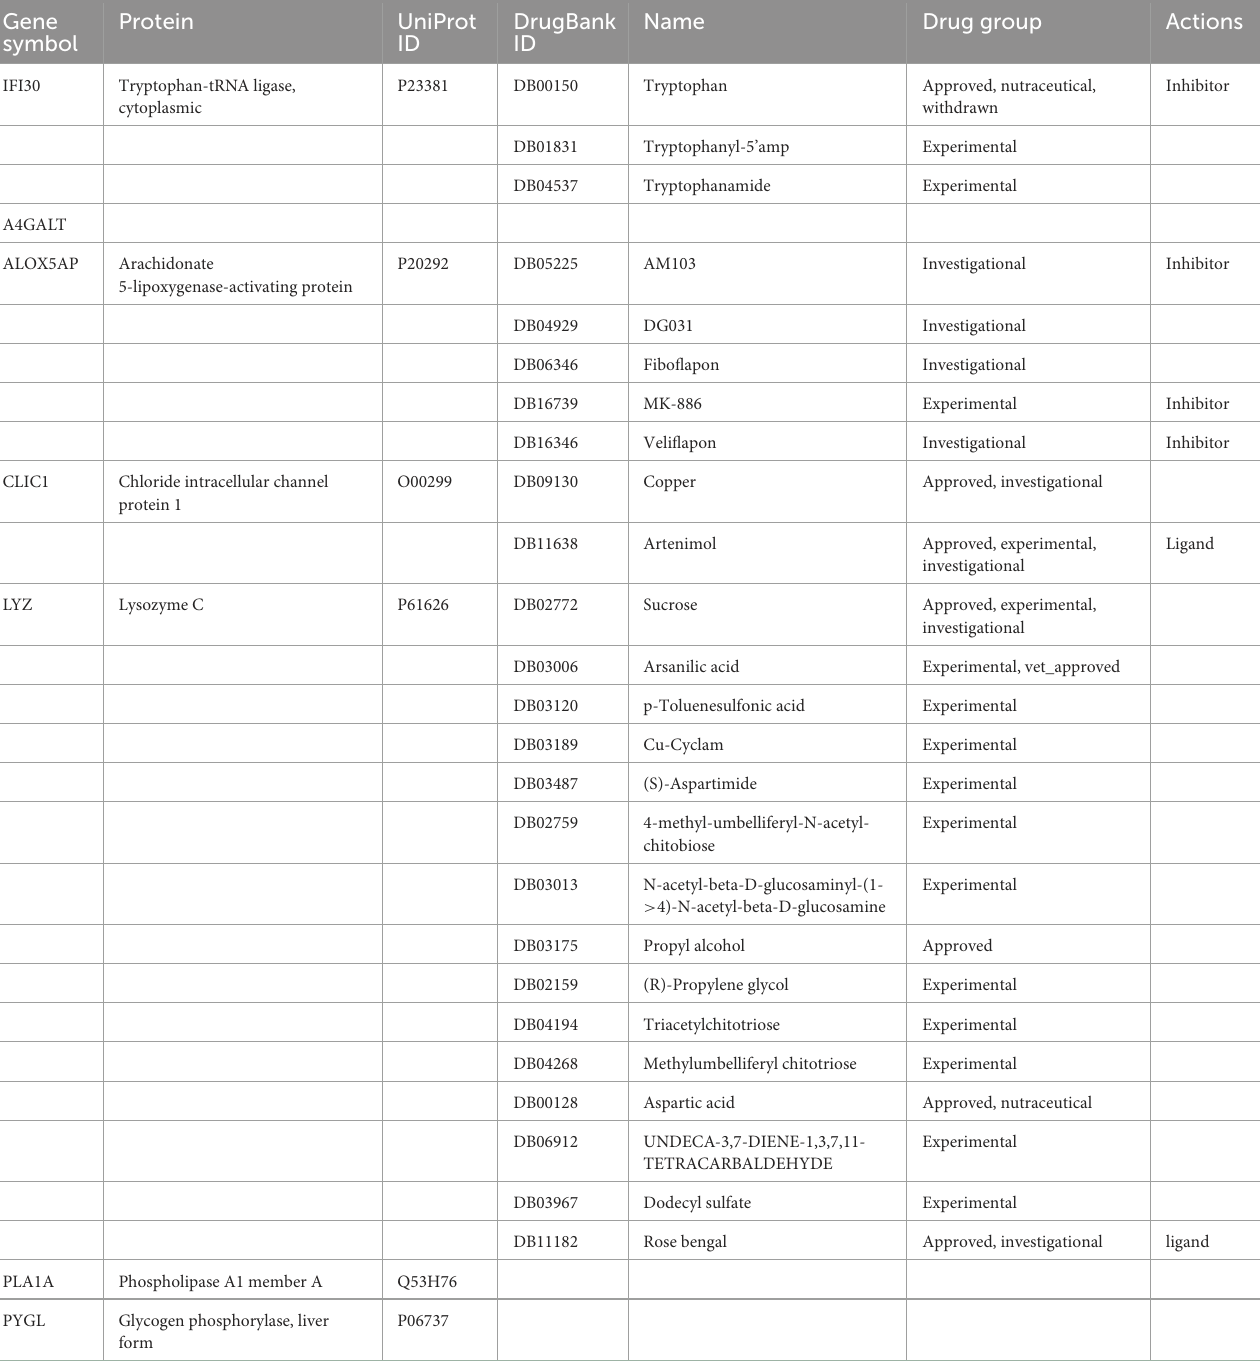
TABLE 1 Drugs targeting these seven hub genes obtained from the DrugBank